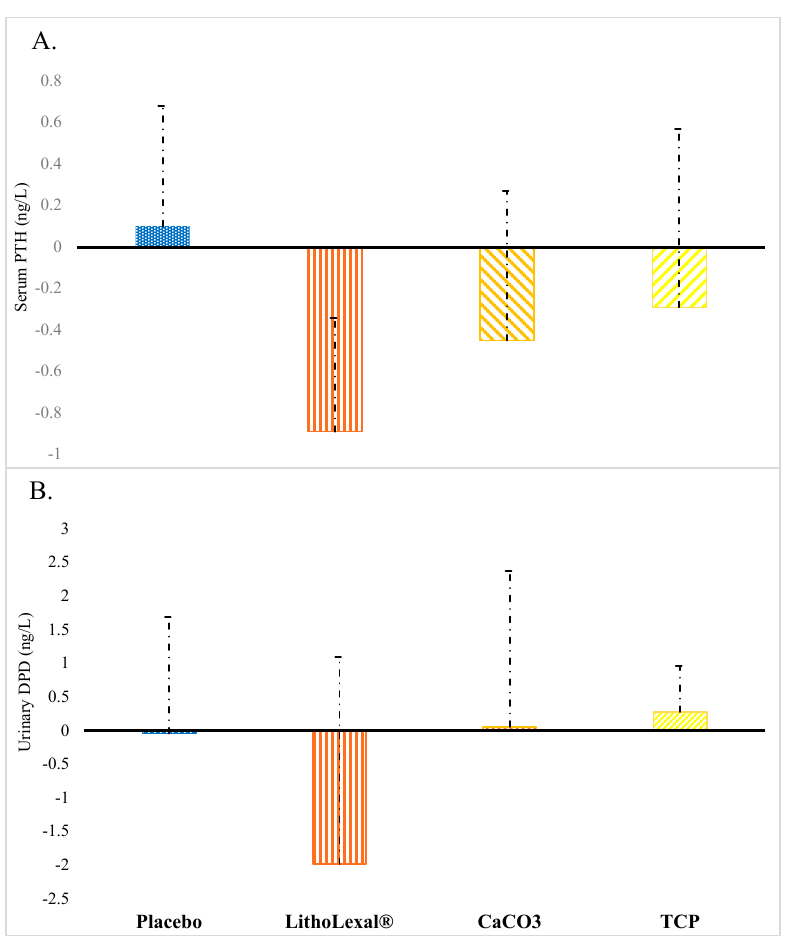
Figure 2. Changes observed in postmenopausal women after three months of treatment with placebo or active intervention in ( A ) serum PTH and ( B ) urinary DPD (a biomarker of osteoclastic ac- tivity). Error bars display standard deviation (SD). Abbreviations: CaCO 3 = calcium carbonate; TCP = tricalcium phosphate; DPD = deoxypyridinoline. This figure is based on data from a clinical study by O’Gorman and colleagues.